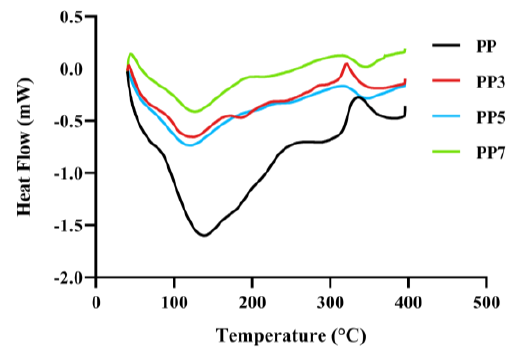
Figure 6. Differential scanning calorimetry (DSC) analysis of PP, PP3, PP5, and PP7.